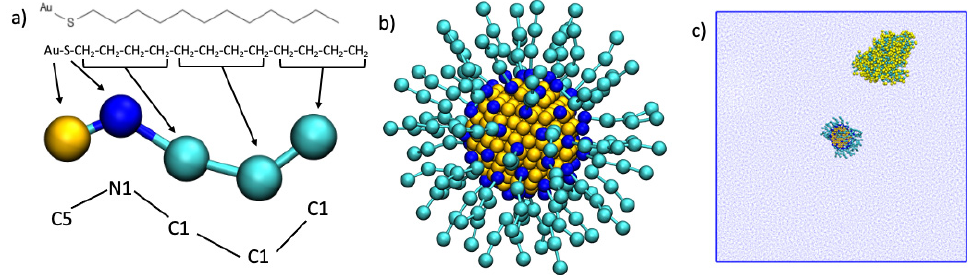
Figure 9. In panel ( a ), the atomistic representation and the cg Martini model mapping of the MUS ligand is shown. in panel ( b ), the cg representation of the all-MUS AuNP before running the simulation is shown. In panel ( c ), the system with the AuNP fixed in the center of the simulation box after some 1s of simulation is shown, where the protein is represented by yellow and cyan beads, and the Martini water is represented with small blue points.